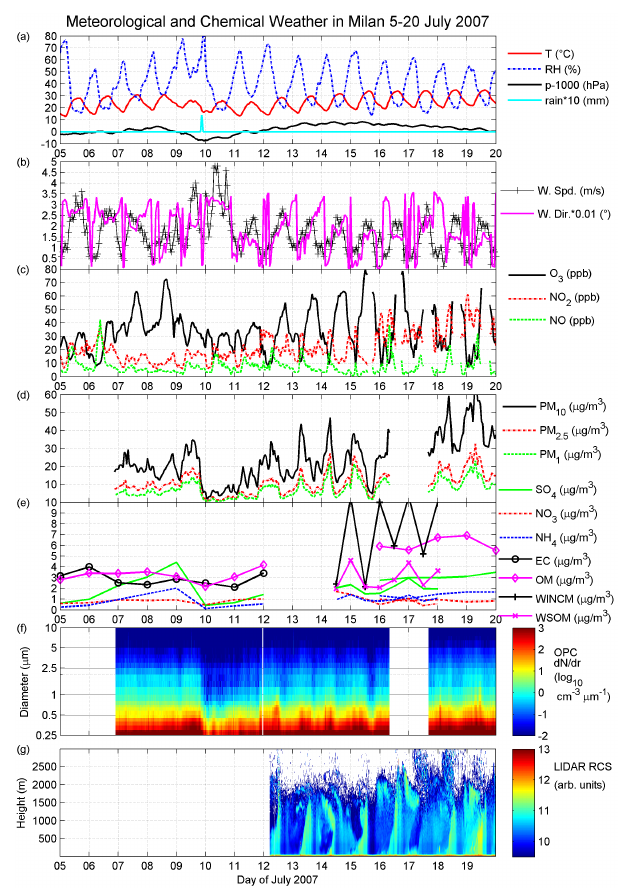
Figure 1. Ground-based observations in Milan during 5–20 July 2007. Panel (a) shows hourly measurements of temperature, rela- tive humidity, pressure and precipitation. Pressure is pressure mi- nus 1000, and precipitation is multiplied by 10 in order to fit the same y axis. (b) Hourly wind speed and wind direction (0 ◦ from the north, 90 ◦ from the east), the latter divided by 100 to fit the same y axis. (c) Hourly ozone, nitrogen dioxide and nitrogen oxide. (d) Particulate-matter mass. Hourly observations of PM 10 , PM 2 . 5 , and PM 1 . (e) Particulate-matter composition. Daily data for sulfate, nitrate, ammonium, elemental carbon and organic matter collected during QUITSAT campaign. Night-time (21:00 to 08:00LST) and daytime (08:00 to 21:00LST) samples of sulfate, nitrate, ammo- nium, water-insoluble carbonaceous matter (WINCM) and water- soluble organic matter (WSOM) collected during AeroClouds cam- paign (14–17 July). (f) Particulate-matter number size distribution; optical particle counter (OPC) hourly average measurements; y axis denotes the size bin. (g) Particulate-matter vertical profile; li- dar range-corrected signal; y axis denotes the height above ground